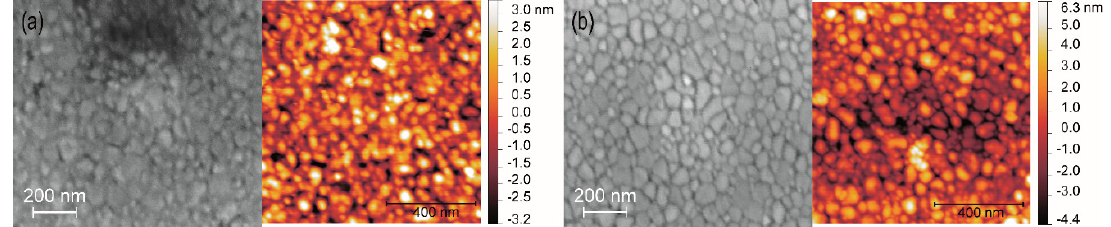
Figure 12. Top-view SEM images (left) and corresponding AFM images (right) of the ink-jet prepared samples on sapphire substrates ( a ) BZY ink- 1 film and ( b ) BZY ink- 2